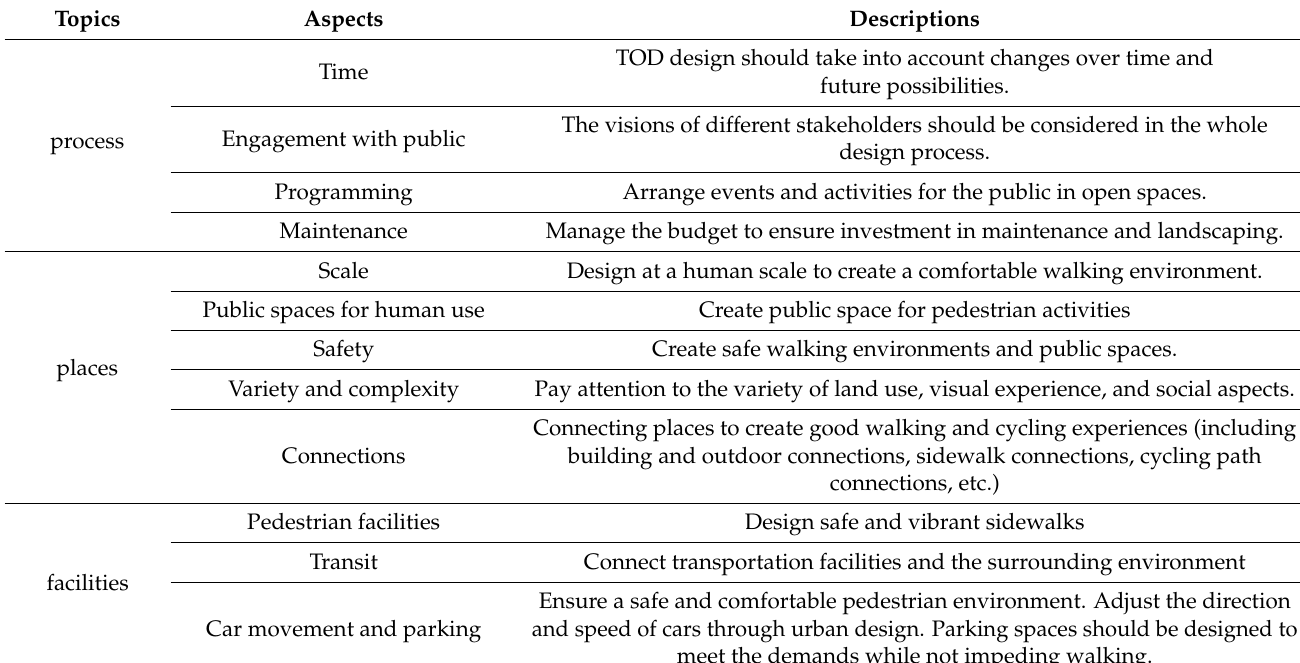
Table 1. The summary of twelve aspects of good urban design initiatives for